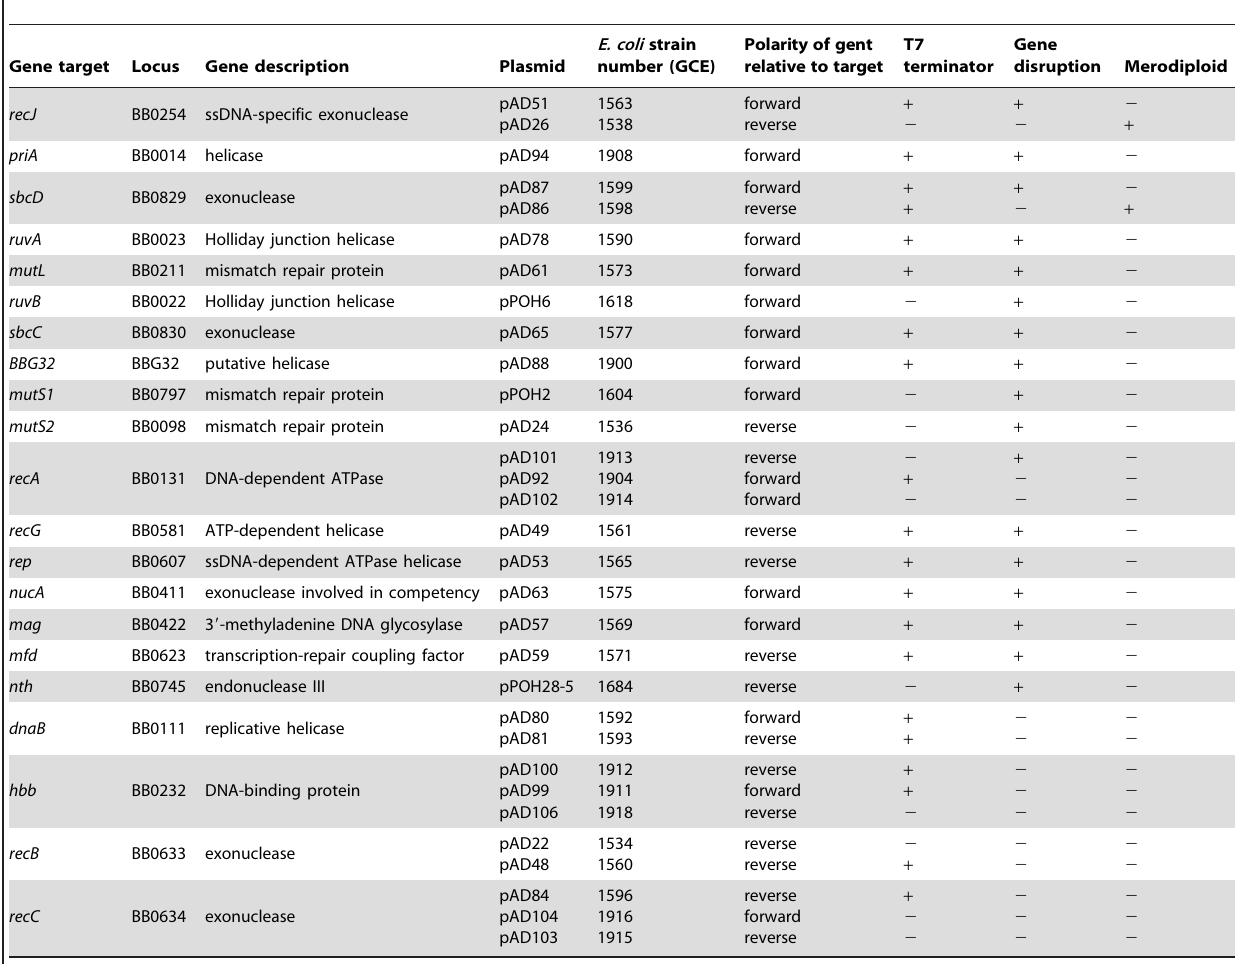
Table 1. Gene disruption targets and knockout plasmid attributes.